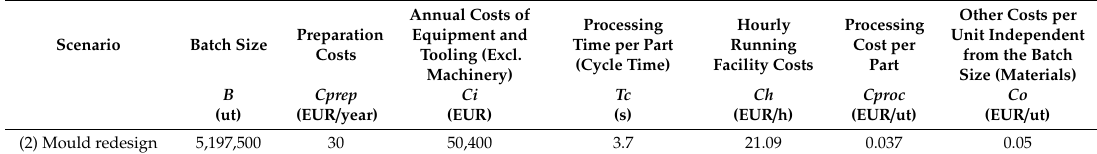
Table 7. Main parameters for the unit cost comparison for the scenario based on the redesign of a full mould with conformal cooling in most surfaces (not only in the